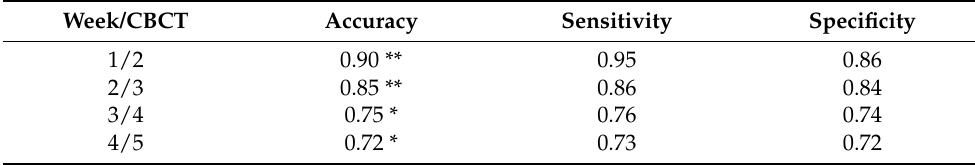
Table 5. Model Performance Per Week of Treatment.